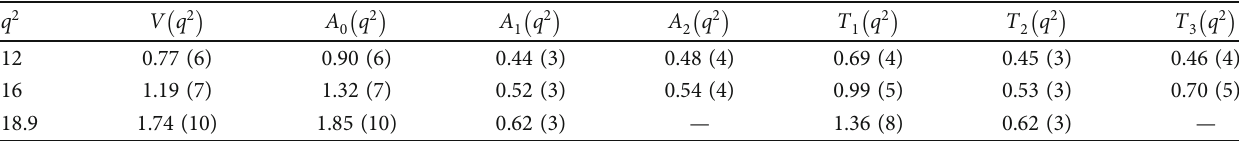
⟶ ϕ transition form factors at two or three reference points [92]. Table 4: The values for the lattice QCD results of the relevant B s (cid:7) (cid:8) (cid:7) (cid:8) A 0 q 2 q 2 V q 2